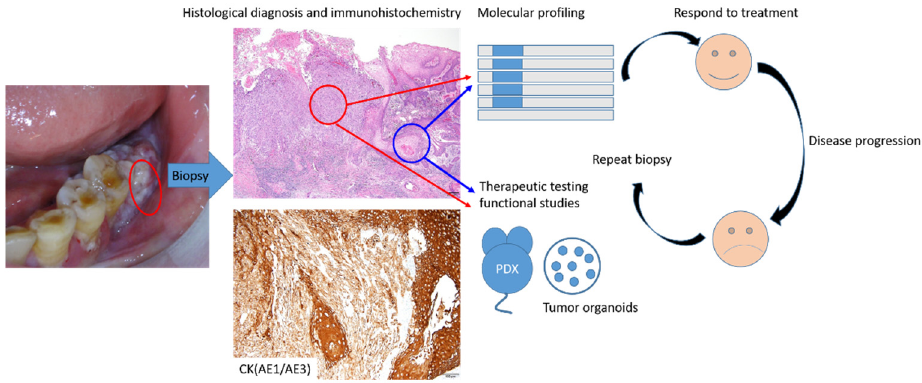
Figure 6. Schematic illustration of precision medicine in oral cancer in the future. PDX, Patient- Derived Tumor